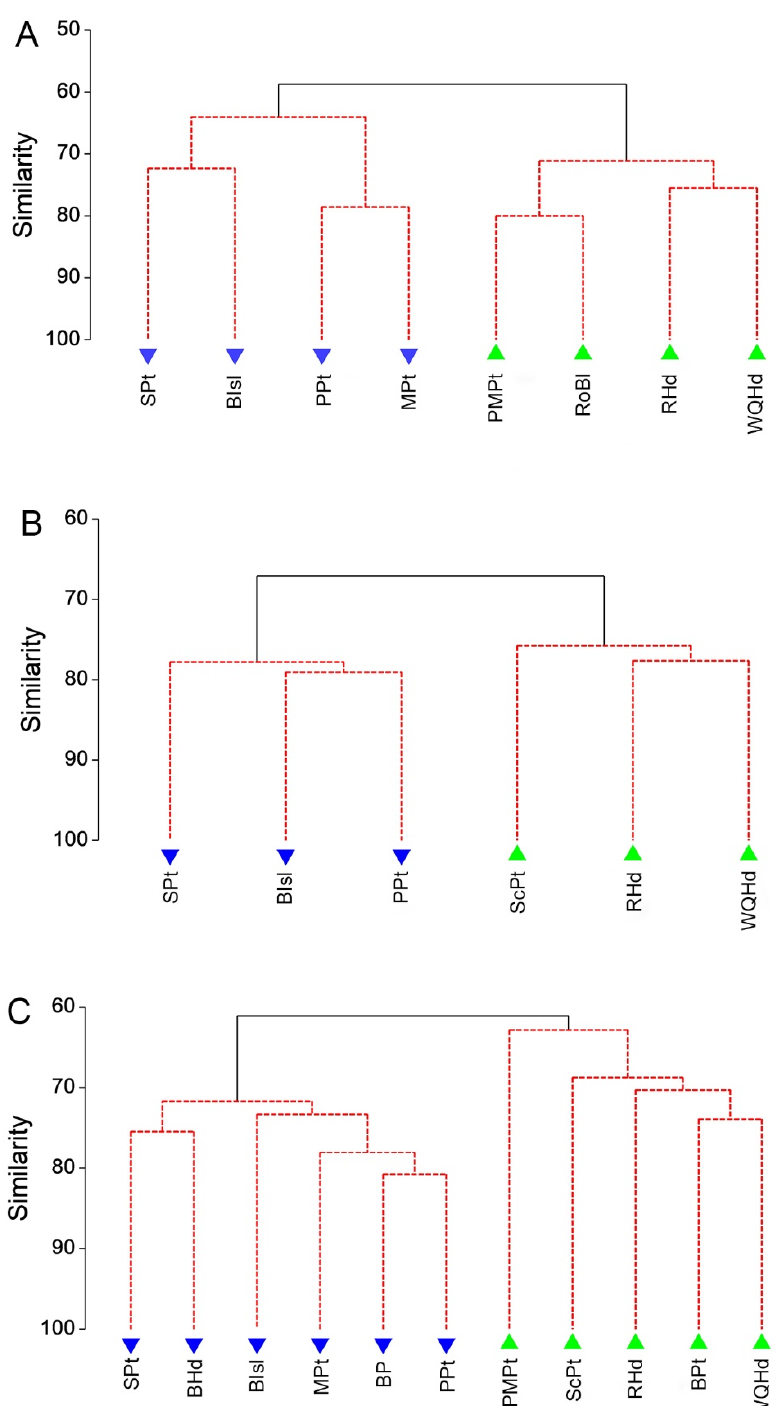
Figure 4. Hierarchical cluster analysis of Bray-Curtis similarities with group average as the cluster mode for rocky intertidal species assemblages. ( A ) 2004; ( B ) 2007; ( C ) 2012. Solid black lines connect samples that differ significantly. Red dashed lines connect samples not significantly different (SIMPROF). Symbology: Blue triangles, southern GoM region; green triangles, northern GoM region. Abbreviations: BIsl, Bailey Island; BHd, Bald Head; BP, Biddeford Pool; BPt, Black Point; MPt, Marshall Point; PPt, Pemaquid Point; ScPt, Schoodic Point; SPt, Sea Point; PMPt, Petit Manan Point; RHd, Red Head; RoBl, Roque Bluffs; WQHd, West Quoddy